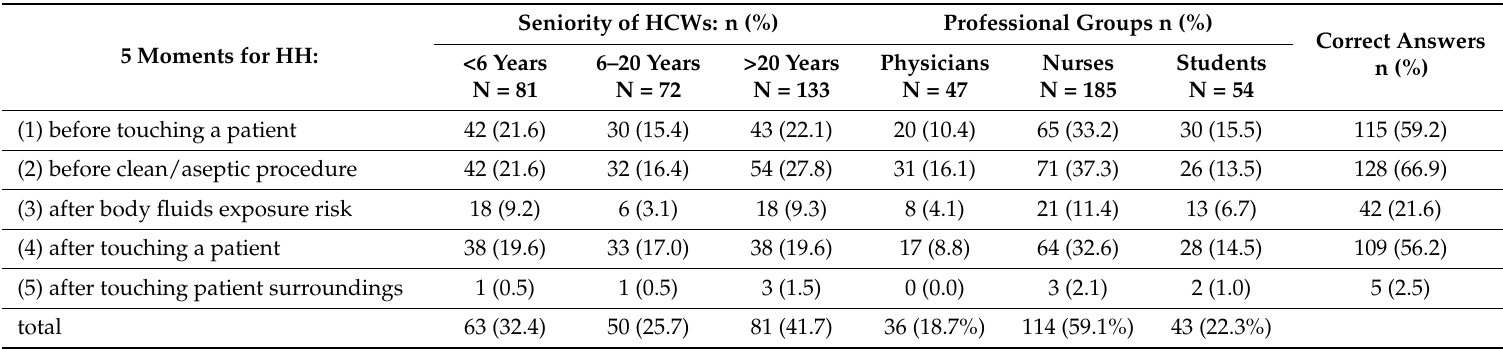
Table 2. Answers to the open question “when should the “5 Moments for HH” be performed?”, taking into account the age of the respondents and HCW professional